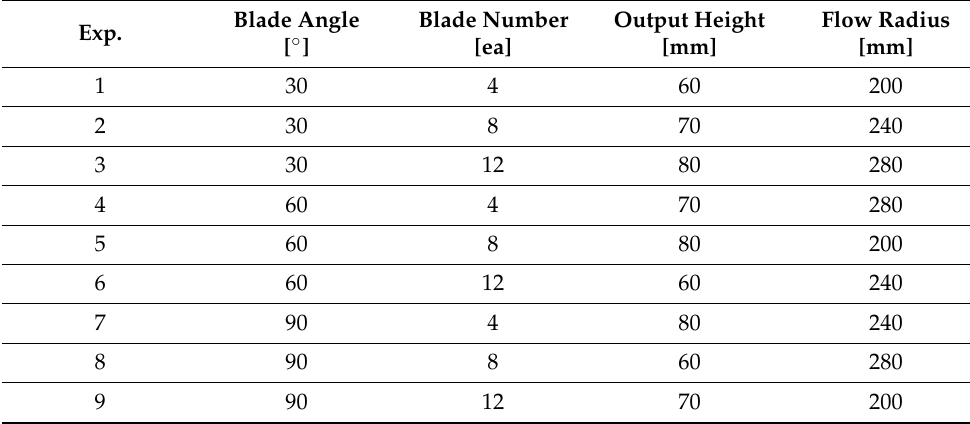
Figure 5. Analysis conditions and model. ( a ) Setup of the inlet and outlet; ( b ) FE model.